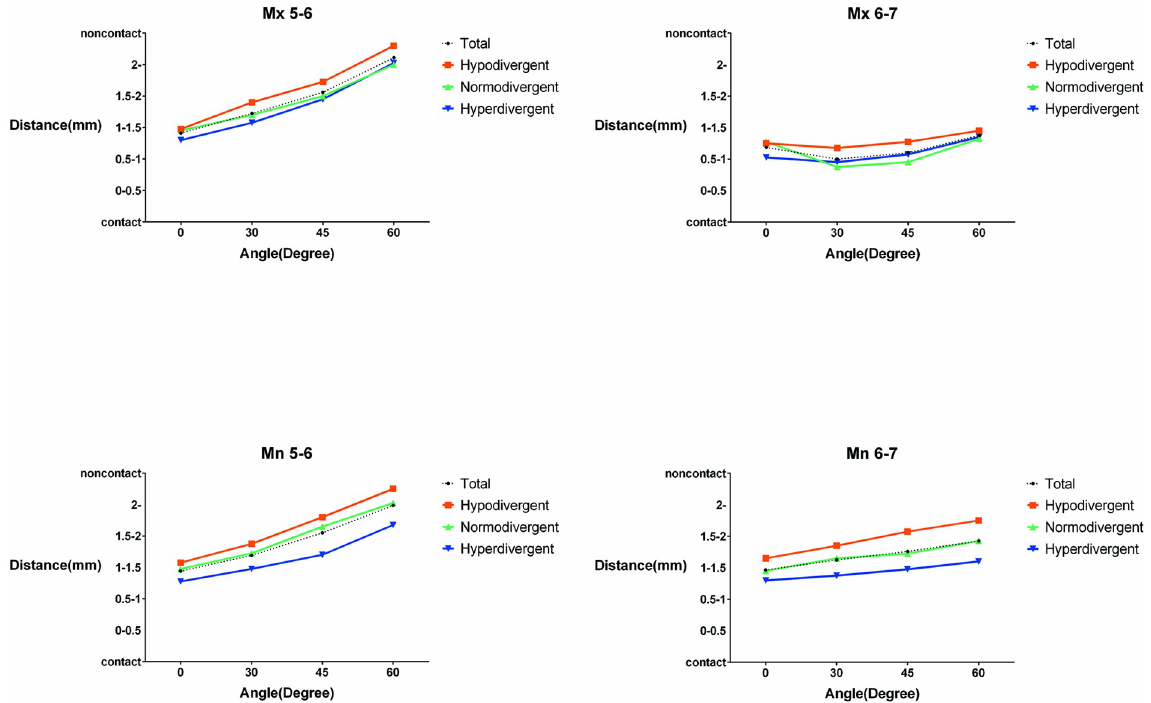
Fig 6. Pictorial representation of miniscrew–root distances. Graphs of mean values of categorical miniscrew–root distances according to miniscrew insertion angles at the Mx 5–6, Mx 6–7, Mn 5–6, and Mn 6–7 regions. Mx, maxilla; Mn, mandible; 5–6, interradicular site between second premolar and first molar; 6–7, interradicular site between first and second